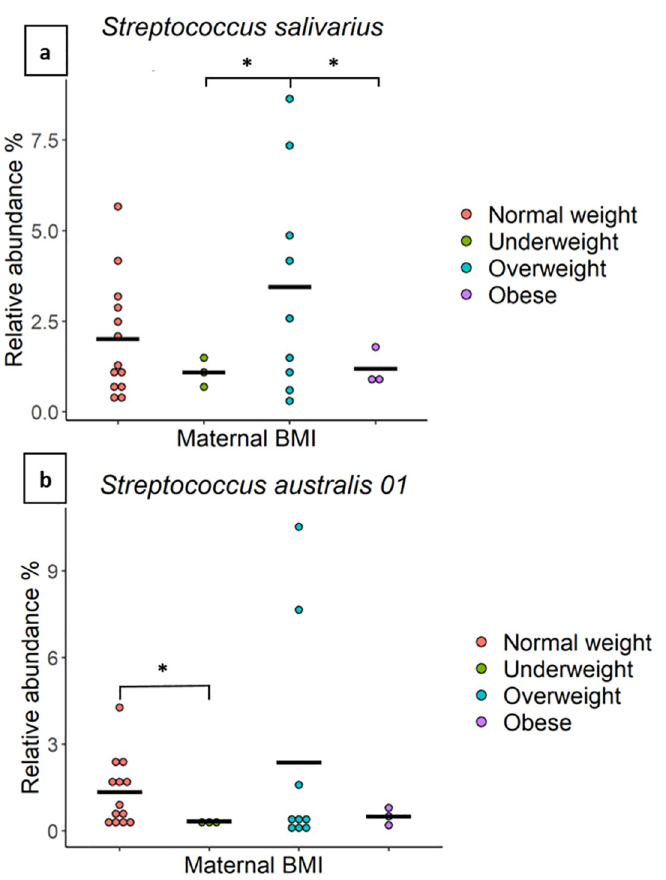
Fig 2. The relative abundance of Streptococcus spp. is associated with maternal BMI. The relative abundance of two OTUs, mapping to (a) Streptococcus salivarius and (b) Streptococcus australis in milk from mothers of different BMI classes (normal weight n = 13, overweight n = 9, obese n = 3, and underweight n = 3). The average value for each group is indicated with a line. � indicate significant